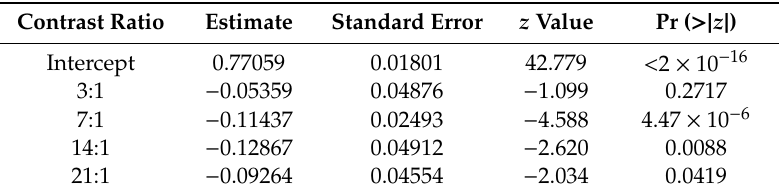
Table 6. Logistic regression analysis results of the contrast ratio. Contrast Ratio